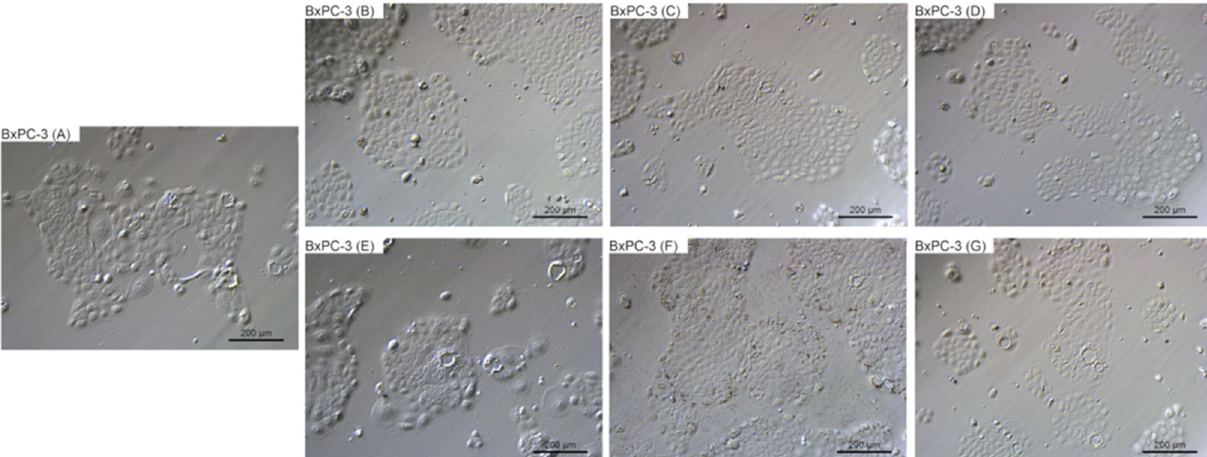
Figure 6. Morphological characterization of the BxPC-3 human pancreatic adenocarcinoma cell line. The cells were treated with metallic NPs at a concentration of 1 mg/L and carbon-based nanomaterials at a concentration of 10 mg/L. The incubation period lasted for 24 h. ( A ) control were treated with ultrapure water, ( B ) cells were treated with Ag, ( C ) cells were treated with Au, ( D ) cells were treated with Pt, ( E ) cells were treated with GO, ( F ) cells were treated with ND, and ( G ) cells were treated with C 60 (OH) 40 .